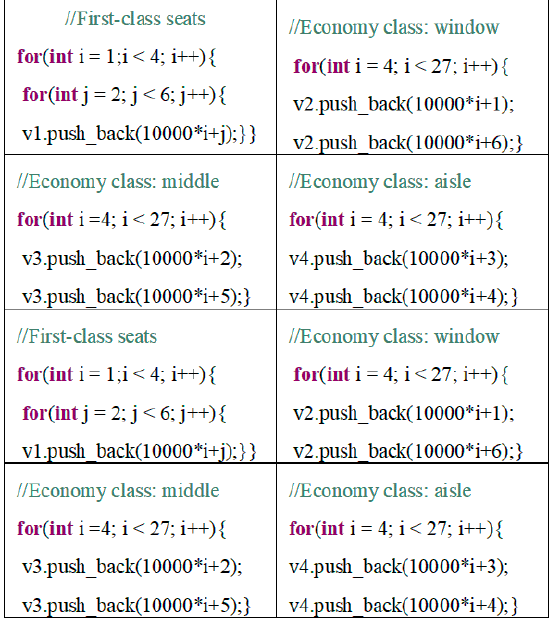
Figure 11. Window Middle Aisle (WMA) seat number generation.